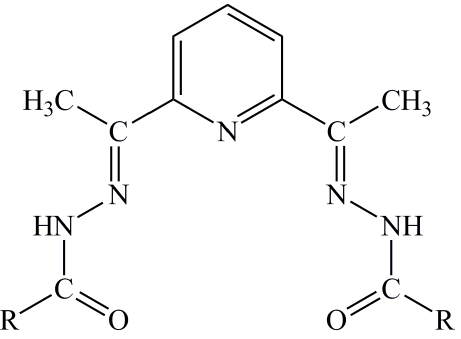
Figure 1. Molecular structure of the pentadentate ligand H 2 dapsc (R = NH 2 ) and its analog H 2 dapbh (R = C 6 H 5 ).